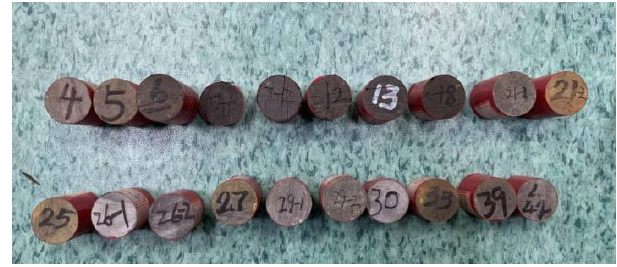
Figure 3. Shale core samples for shear test.